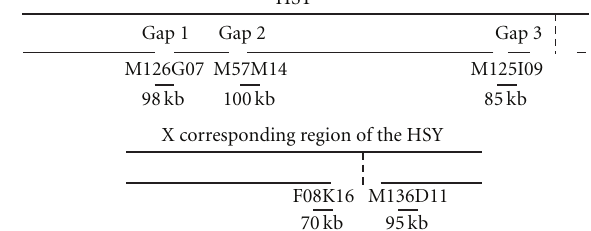
Table 2: GenBank accession numbers of papaya BACs. BAC ID